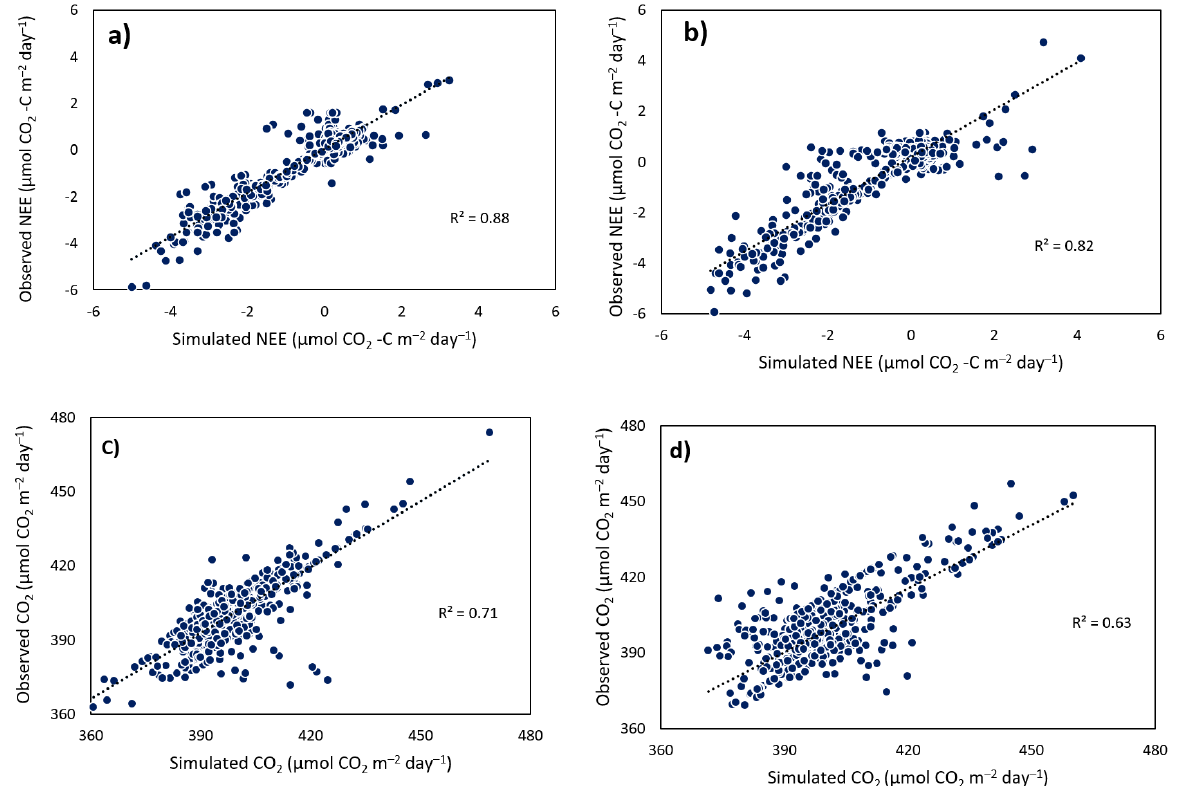
Figure 9. Predicted and observed daily CO 2 emission in the calibration and validation periods.